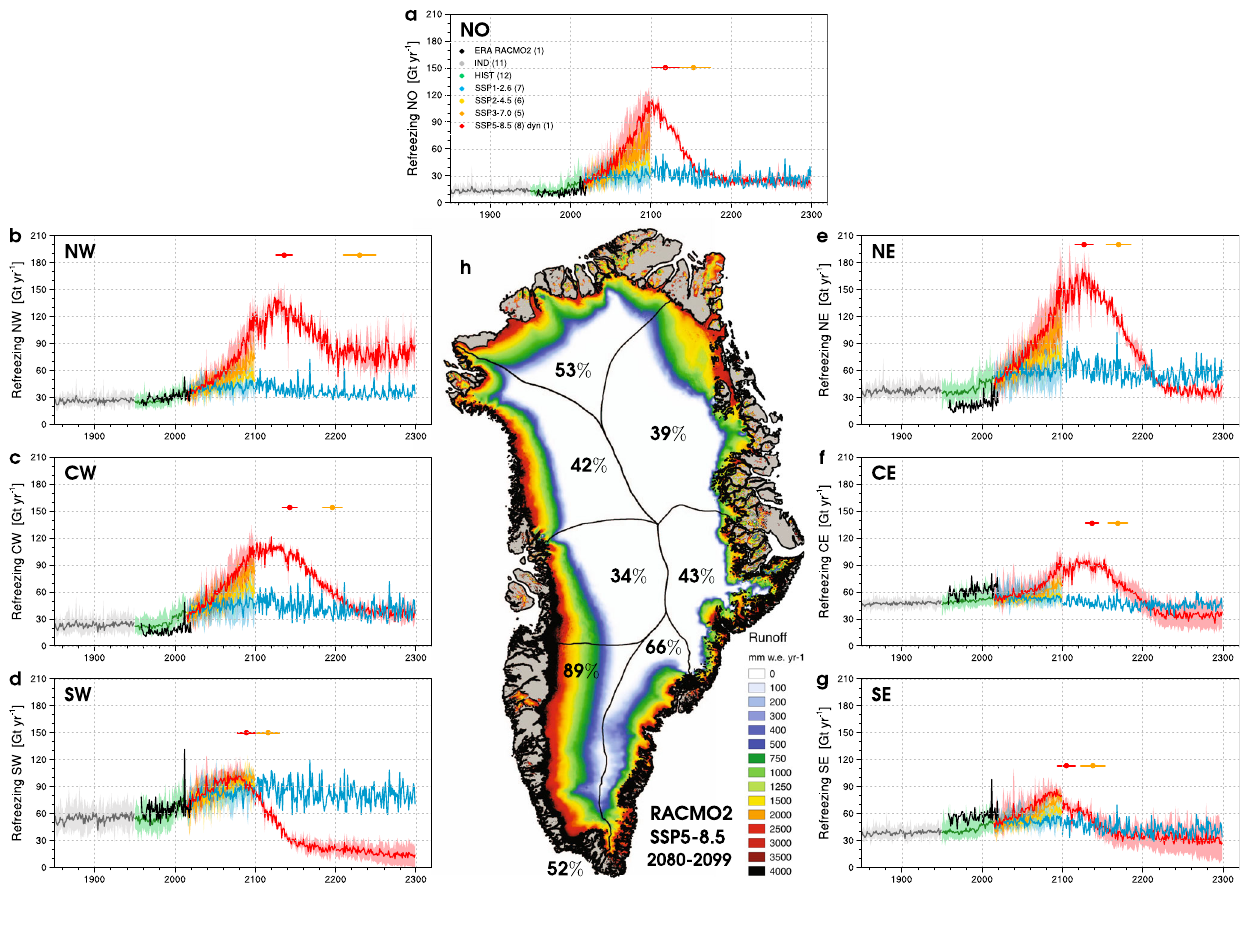
Fig. 3 | Regional peak refreezing by 2200. a – g Time series of sector-integrated refreezing for the period 1850 – 2300. Thick coloured lines represent ensemble mean refreezing at 1 km from 11 pre-industrial (IND), 12 historical (HIST) and 27scenarioprojections,i.e.,SSP1-2.6(6CESM2and 1RACMO2members),SSP2-4.5 (6 members), SSP3-7.0 (5 members), and SSP5-8.5 (8 CESM2 and 1 RACMO2 members). One CESM2 SSP5-8.5 scenario includes ice dynamics (dyn). Coloured bands represent the maximum and minimum refreezing within each ensemble.